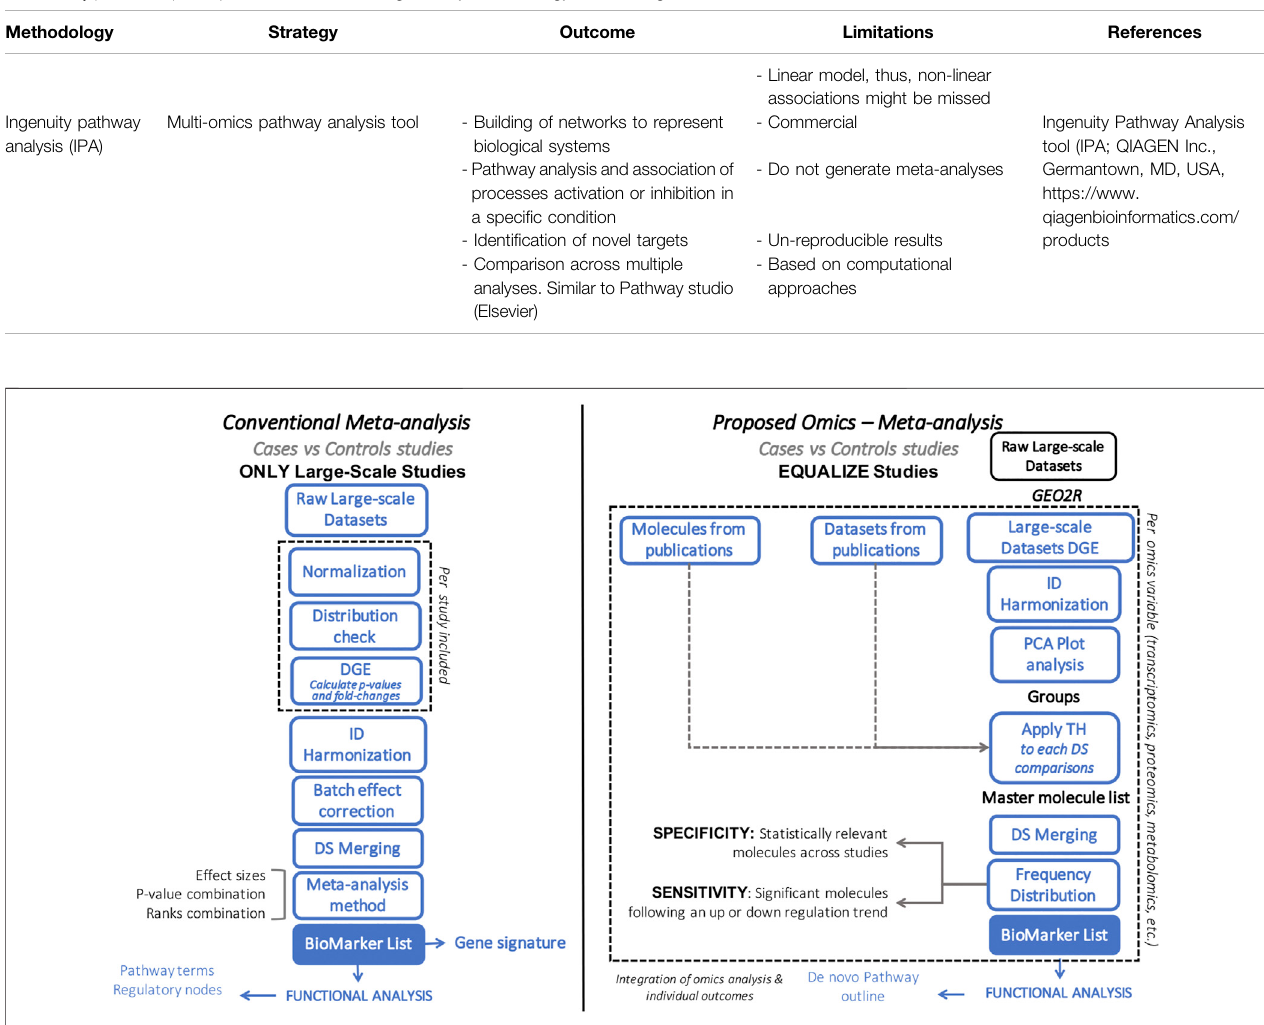
FIGURE1| Flowchartcomparingconventional(left)vs.ourproposed(right)meta-analyticapproach.Blueboxrepresentssimilaritiesbetweenapproaches.Dashed line highlights the main differences between approaches.